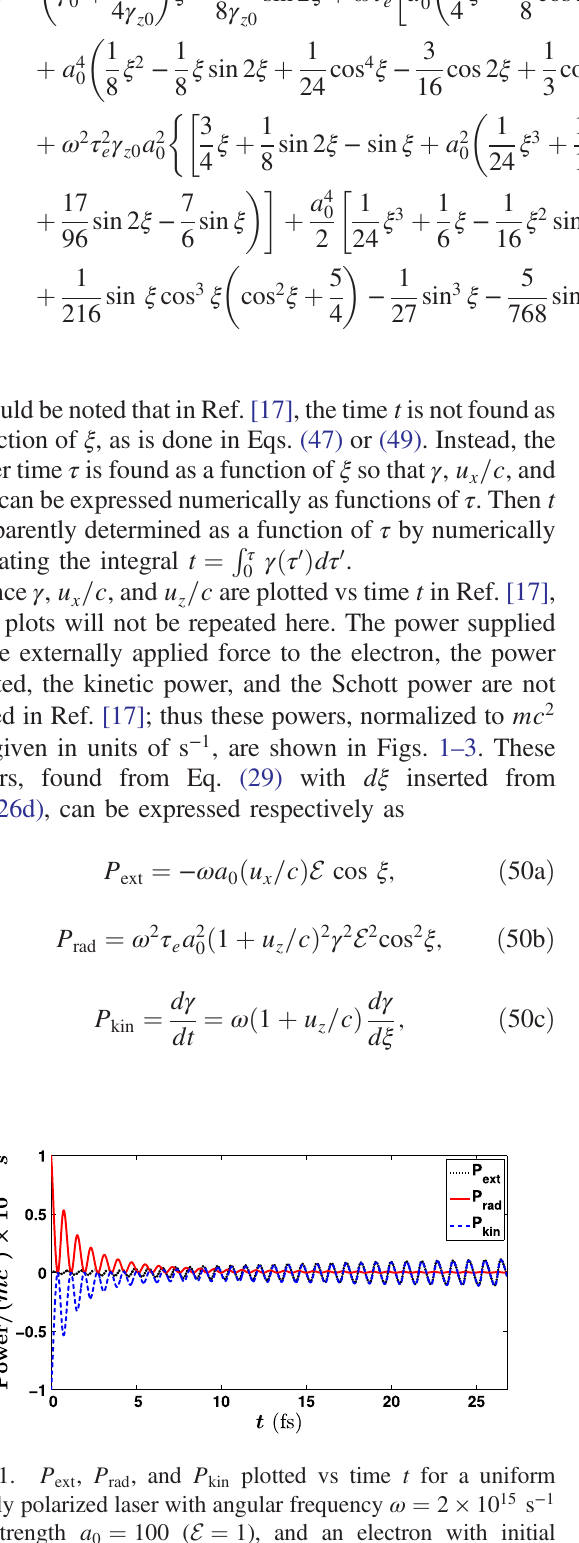
FIG. 3. Comparison of P linearly polarized plane wave with parameters given in Fig.